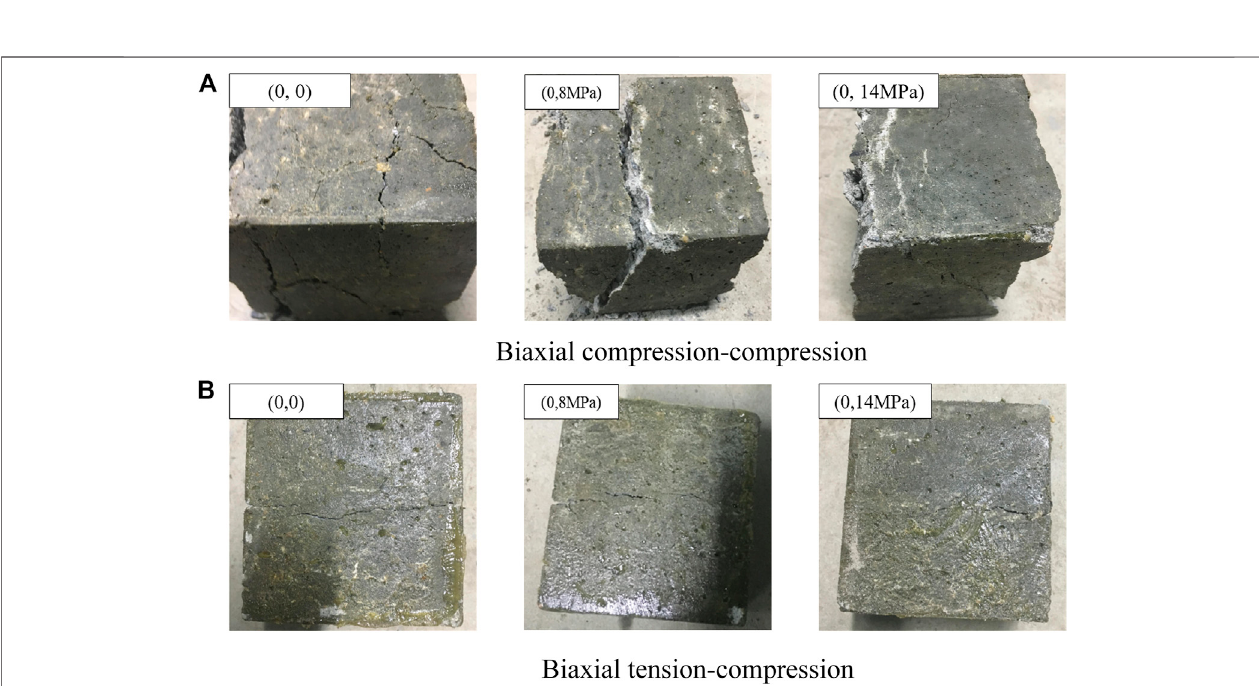
FIGURE 3 | The biaxial loading experiment program of SCC.